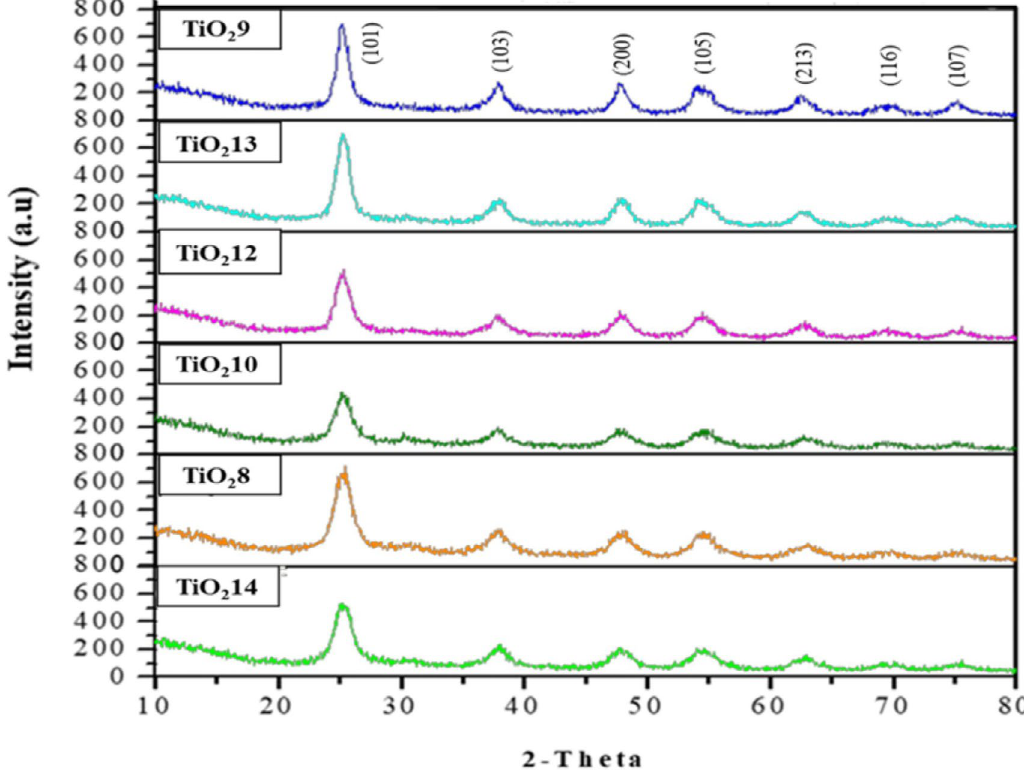
Fig. 4. XRD spectra of the TiO